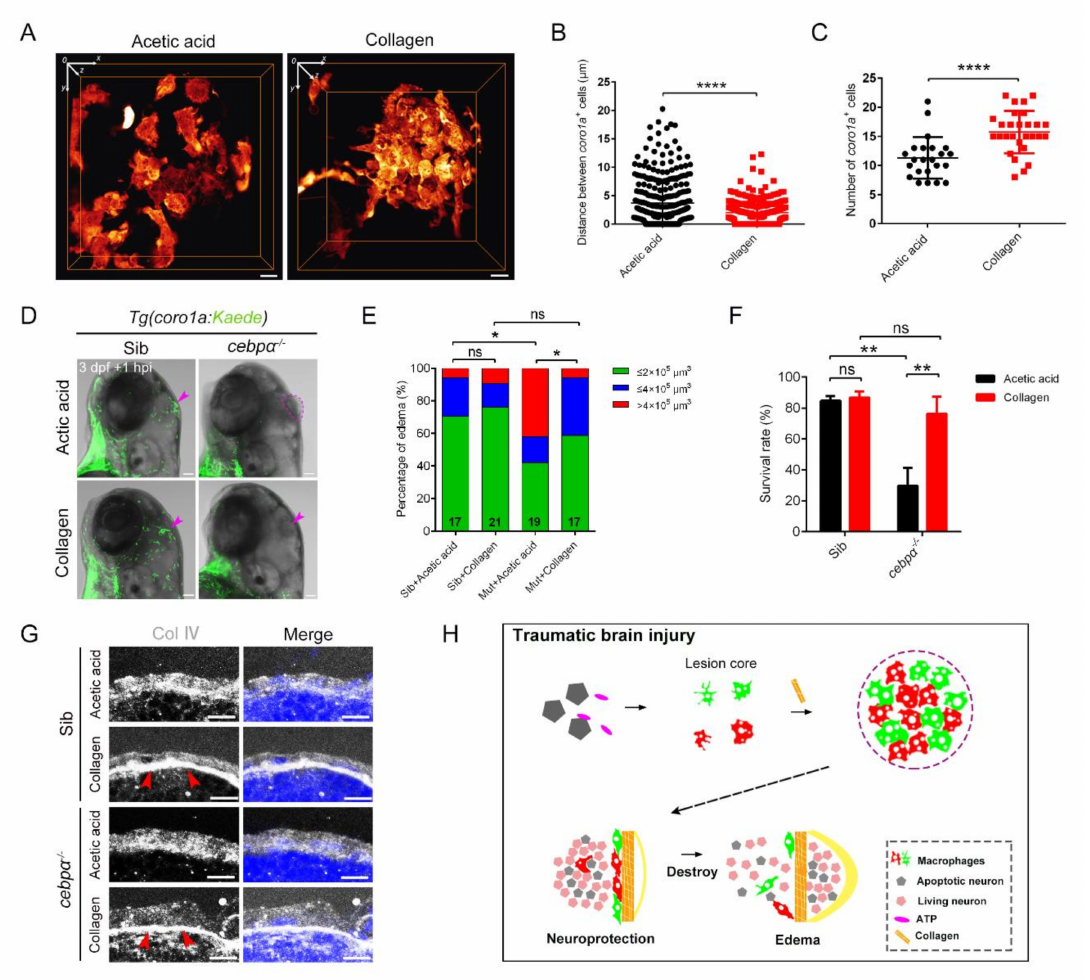
Figure 8. Collagen was crucially involved in the construction of the honeycomb network structure and the protection of brain integrity. ( A ) The distribution of macrophages after collagen/acetic acid injection in Tg(coro1a:DsRed) embryos at 1 hpi. Scale bar, 10 µ m. ( B ) Statistical analysis of distances between the coro1a -DsRed + cells in ( A ). Acetic acid, 3.73 ± 0.21 µ m n = 340; collagen, 2.05 ± 0.10 µ m n = 351. Acetic acid, collagen solvent. ( C ) Statistical number of aggregated coro1a + cells in ( A ). Acetic acid, 11.30 ± 0.75 n = 23; collagen, 15.75 ± 0.69 n = 28. ( D ) The bright field and fluorescent images of coro1a -Kaede + cells and edema-like symptoms (purple arrowheads and dashed line) in sibling and cebp α mutant with collagen/acetic acid injection. Scale bar, 100 µ m. ( E , F ) Statistics of edematous symptoms ( E ) and survival rate ( F ) after collagen/acetic acid injection in cebp α mutant and sibling. ( G ) The immunofluorescence staining of collagen (Col IV) in cebp α mutant after injection of collagen. Scale bar, 10 µ m. Red arrowheads indicate dense collagen layers. ( H ) Diagram of our results. The rapid and efficient construction of the honeycomb network structure by aggregated macrophages/microglia required nucleotide-mediated migration and collagen supportive tight junctions. The honeycomb network structures played an important role in the integrity of the damaged brain to protect the brain components inside. (Data are shown as mean ± SEM. ns , no significance; *, p < 0.05; **, p < 0.01; ****, p <